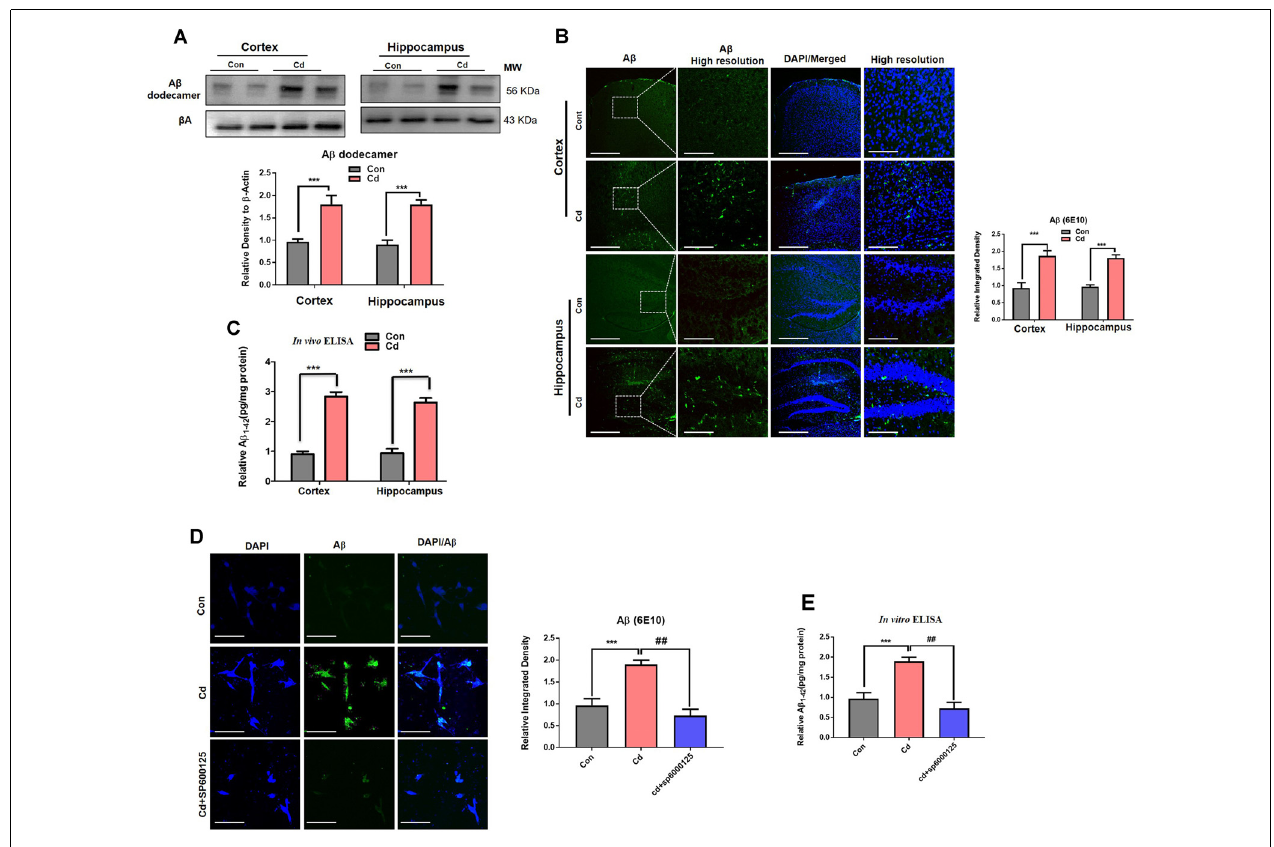
FIGURE 7 | Cd exposure escalated the amyloidogenic pathway through activation of p-JNK. (A) Western blot images against A β oligomer in the cortical and hippocampal regions of the brain and their respective histograms. β -Actin was used as a loading control. The histograms represented as the means ± SEM ( n = 7 mice/group) for three repeated and reproducible independent experiments. Significance = *** p < 0.001; Student’s unpaired t -test. See Supplementary Figure 4 for uncropped and original blots. (B) Representative immunofluorescence images of A β (green: FITC and blue: DAPI) in the cortical and hippocampal regions of the mouse brain. The histograms represented as the means ± SEM for n = 5 mice per group, and the number of independent experiments = 3. Magnification: 10 × . Scale bar = 50 µ m. Significance = *** p < 0.001; Student’s unpaired t -test. (C) The ELISA results for A β 1–42 in the homogenates of the cortical and hippocampal regions of the brain. The histograms represented as the means ± SEM ( n = 7 mice/group) for three repeated and reproducible independent experiments. Significance = *** p < 0.001; Student’s unpaired t -test. (D) The immunofluorescence images of A β (green: FITC and blue: DAPI) in the hippocampal neuronal HT22 cells exposed to Cd (10 µ M) and SP600125 (20 µ M). The data are indicated as the ± SEM for n = 5 images per group, and the number of independent experiments = 3. Significance = *** p < 0.001; ## p < 0.01; one way ANOVA followed by Tukey’s test. (E) The ELISA results for A β 1–42 in the cell lysates of hippocampal neuronal HT22 cells exposed to Cd (10 µ M) and SP600125 (20 µ M). The data are indicated as the ± SEM for n = 5 per group, and the number of independent experiments = 3. Significance = *** p < 0.01; ## p < 0.01; one way ANOVA followed by Tukey’s